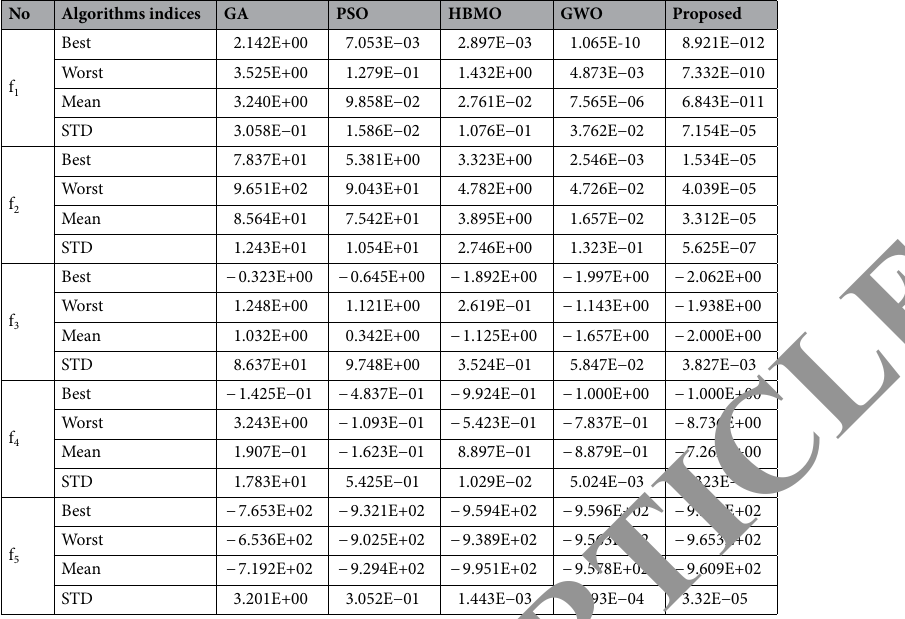
Table 8. Statistical results obtained different algorithms through 30 independent runs on mentioned benchmark functions, Best, Worst, Mean and STD denotes the best solution, the worst solution, the mean solution and the standard deviation, respectively.